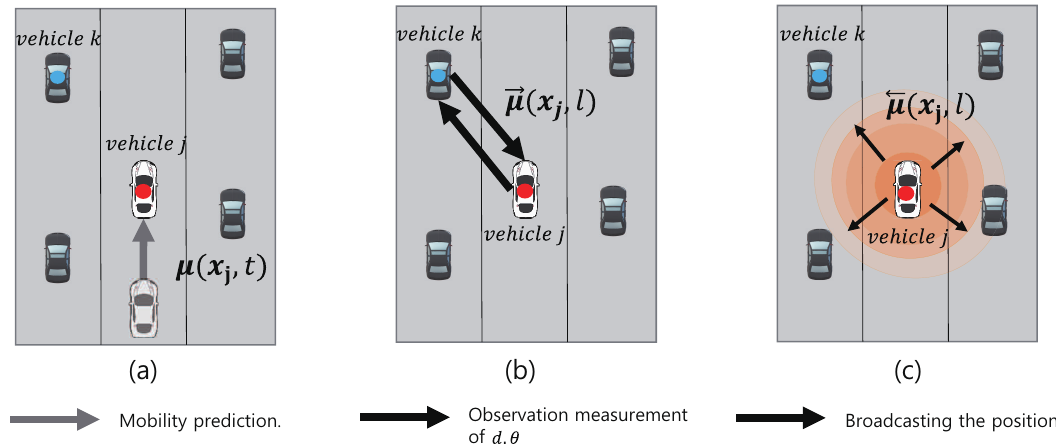
Figure 4. Three steps of proposed algorithm at time t : ( a ) mobility prediction step ( b ) measurement update step ( c ) message broadcast step.